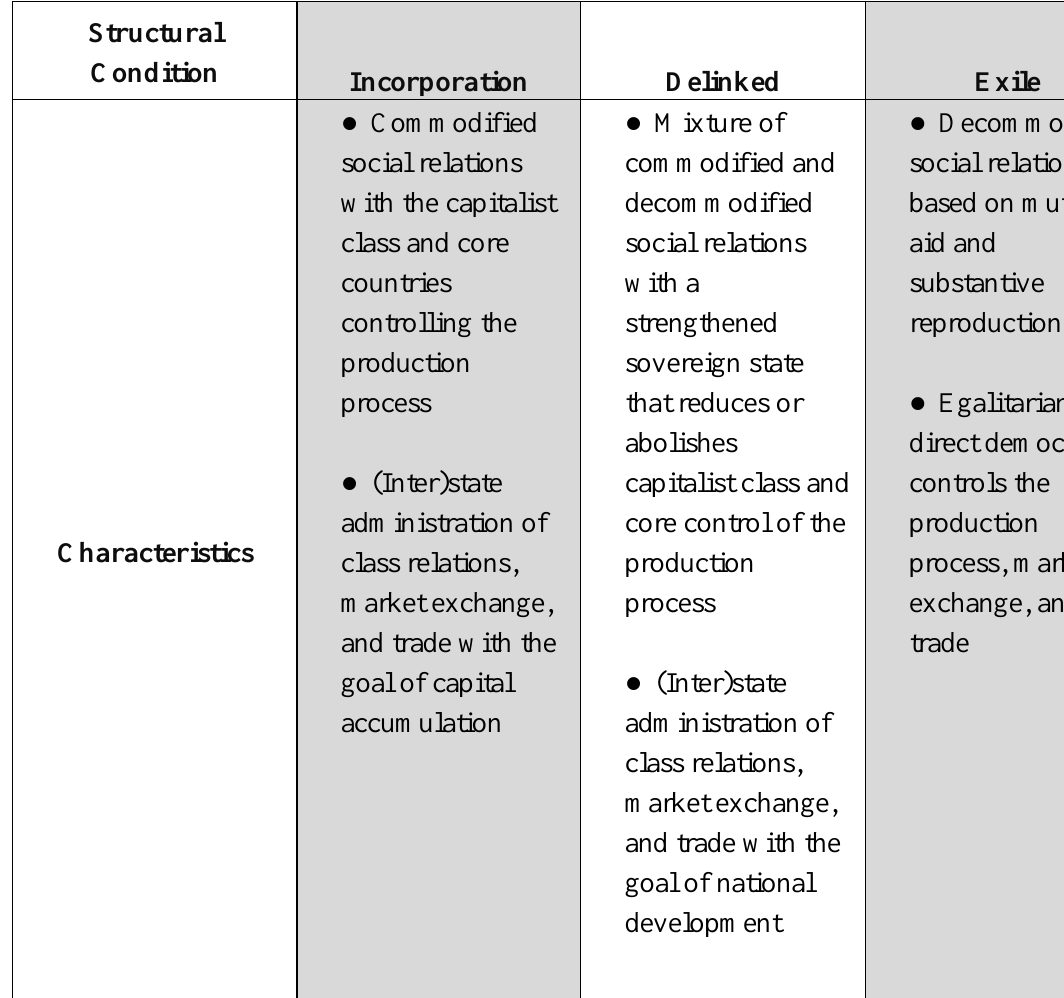
Table 1. Characteristics of Structural